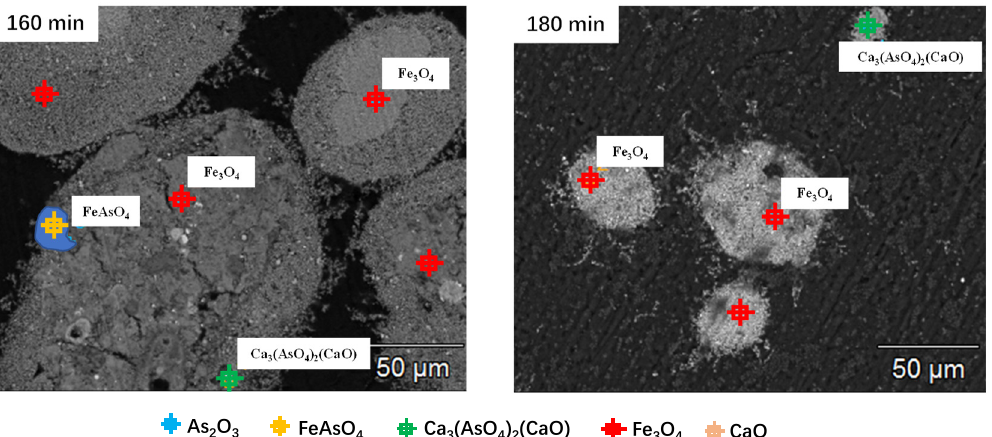
Figure 15. EPMA photos of the precipitate roasted at different roasting times.